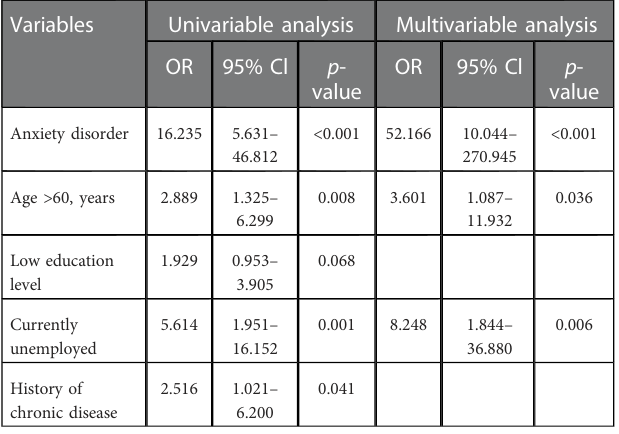
TABLE 4 Univariable and multivariable risk factor analyses for depression. Variables